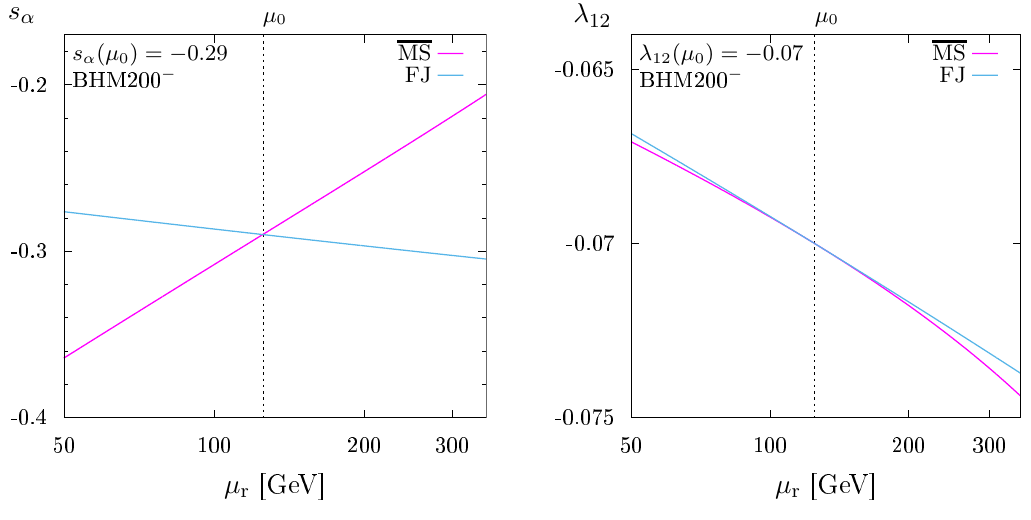
Figure 25 . As in (cid:12)gure 10, but for benchmark scenario BHM200 (cid:0) . of M and (cid:21) are (cid:12)xed according to scenario BHM200 (cid:0) . The plots on the left (right) are 12 H obtained using the MS (FJ) input scheme and converting s and NLO (EW + QCD) results are represented, respectively, by dashed and solid lines. Where relevant, green lines represent the SM value. The vertical dashed lines at s